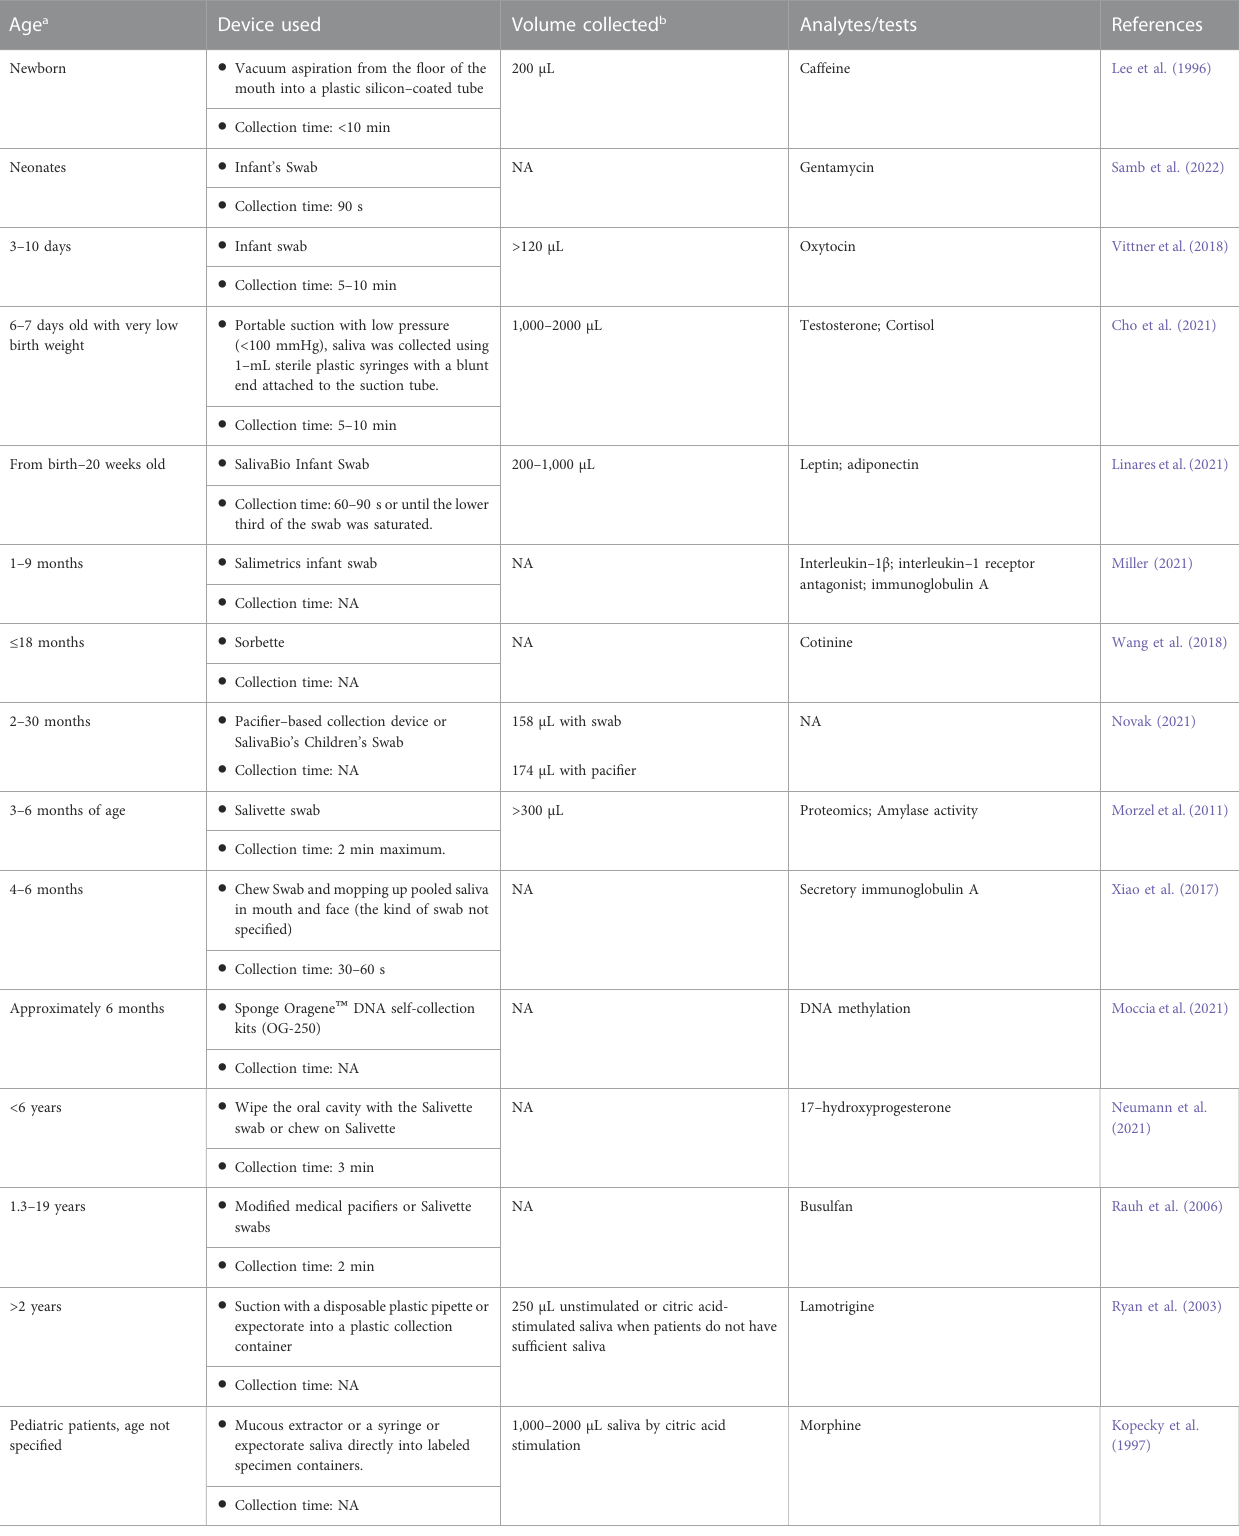
TABLE 4 Studies of saliva collection in